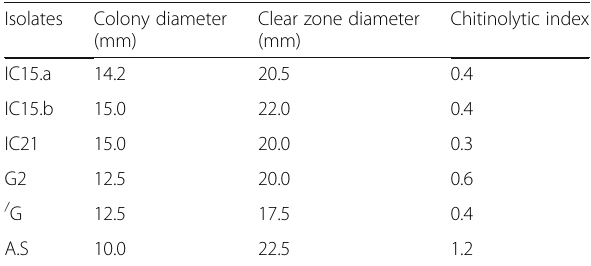
Table 1 Qualitative chitinolytic activity of the isolated bacteria on colloidal chitin media Isolates